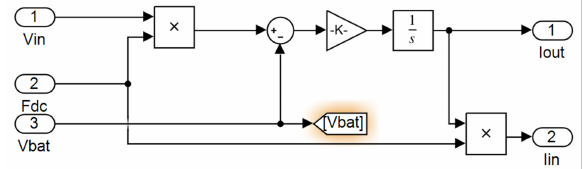
Figure 5. Model of the bidirectional converter.